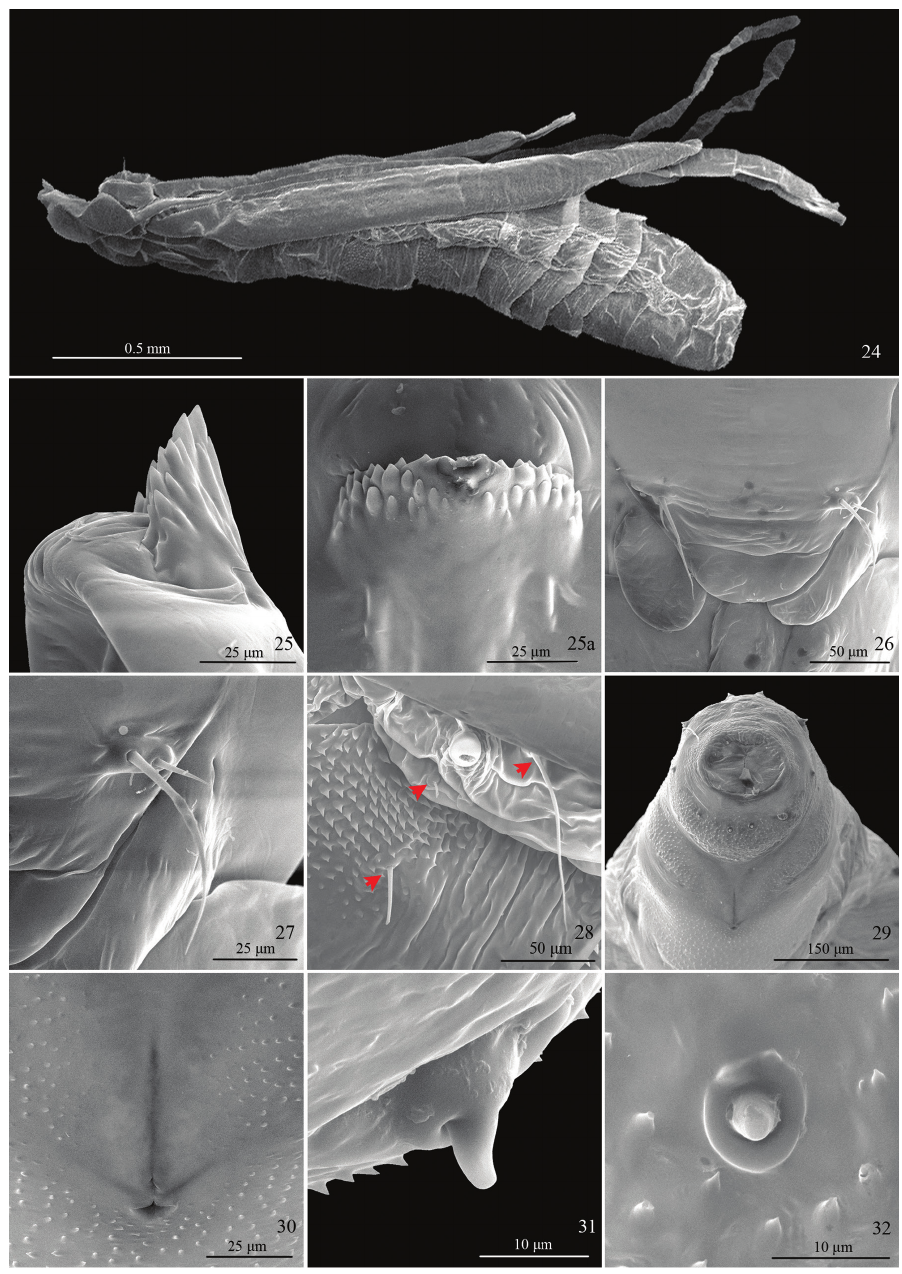
Figures 24−32. Pupal characters of Telamoptilia grewiae sp. n. 24 Pupa, lateral view 25 Frontal process (cocoon cutter), lateral view 25a Frontal process (cocoon cutter), ventral view 26 Two pairs of sensillae on head 27 Close-up of the paired sensillae on head 28 Setae on A2, dorsal-lateral view, arrows indicating the positions of setae 29 Segments A9−10, ventral view 30 Genital orifice 31 Lateral cremaster, lateral view 32 Ventral cremaster, ventral